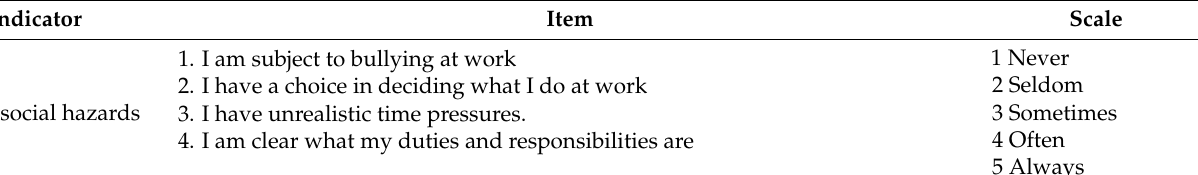
Table A2. List of the items used for measuring employee